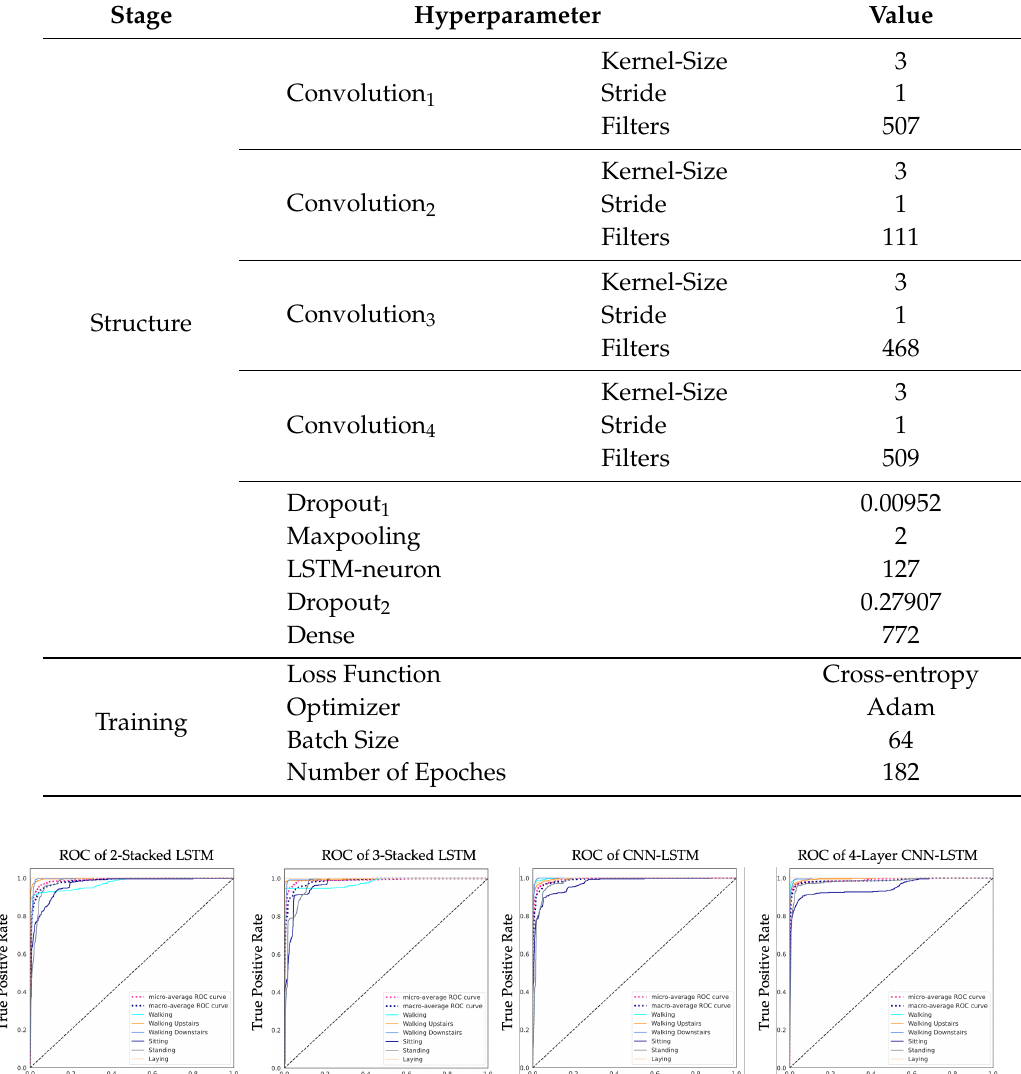
Table 7. The summarized hyperparameters for 4-layer CNN-LSTM network found by SigOpt.